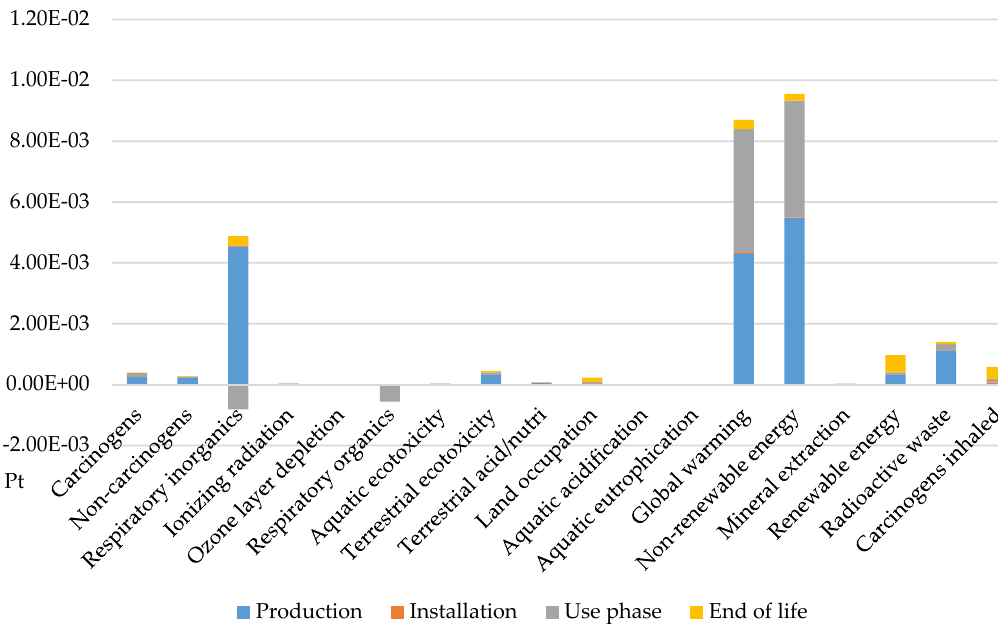
Figure 3. Weighted results by impact categories of 1 m 2 of nanoTiO 2 self ‐ cleaning coated float glass.